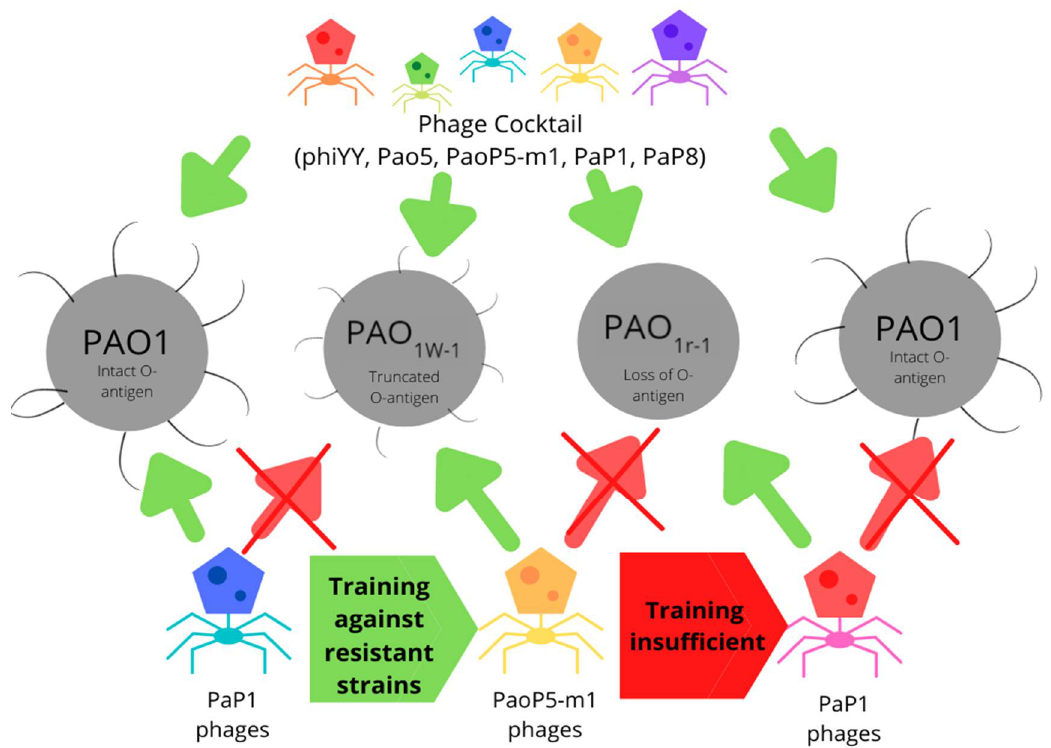
Figure 3. Training of strains effective against phage-resistant bacterium employing truncated O- antigen as a resistance mechanism. Phage cocktails demonstrate effectiveness against all wild-type and resistant strains